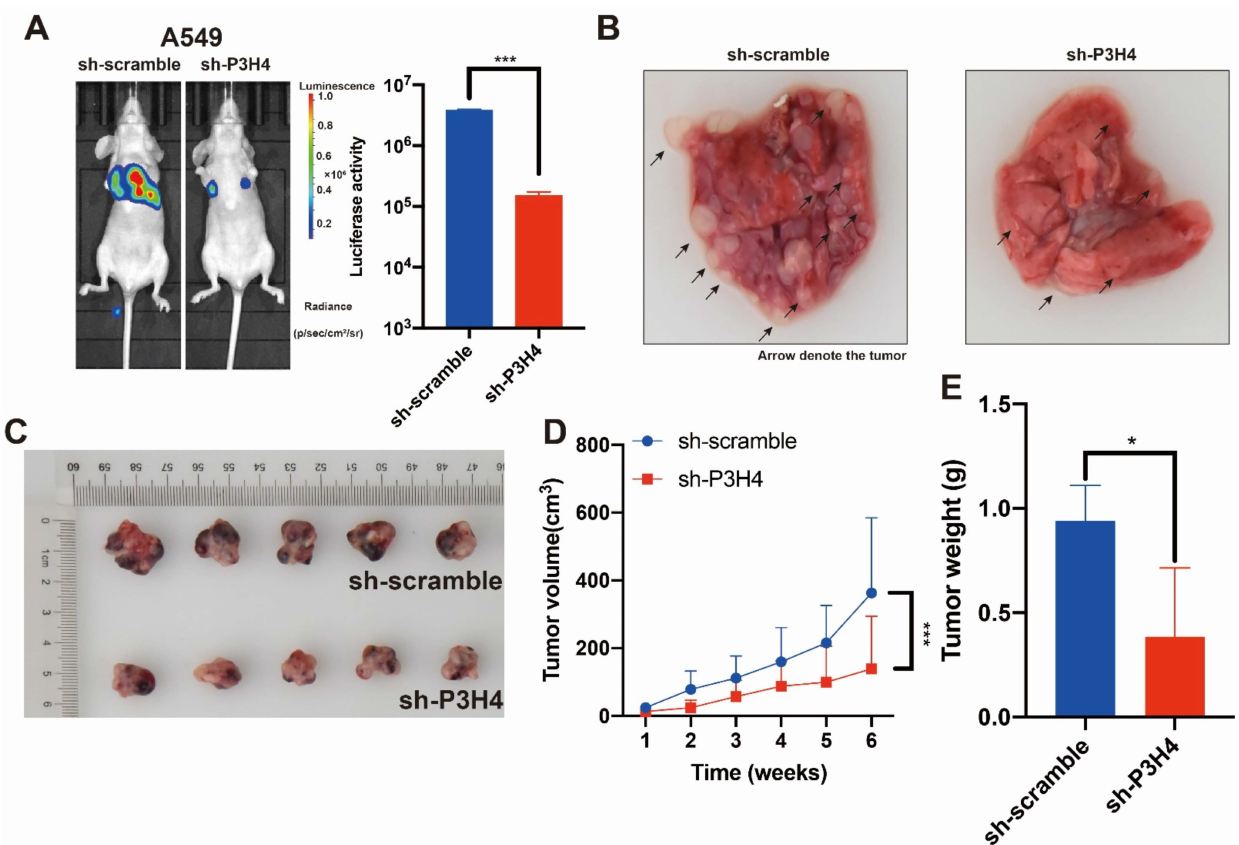
Figure 3. The malignant progression of LUAD is suppressed by P3H4 knockdown in vivo. ( A ) The metastasis of A549 cells was suppressed by P3H4 knockdown in vivo. ( B ) The metastatic nodes are indicated by arrows (*** p < 0.001 vs. sh-scramble, two-tailed unpaired Student’s t test, n = 5). ( C – E ) The proliferation of A549 cells is decreased by sh-P3H4 lentivirus (*** p < 0.001 vs. sh-scramble, multiple-comparison two-way ANOVA, n = 6. * p < 0.05 vs. sh-scramble, two-tailed unpaired Student’s t -test, n =